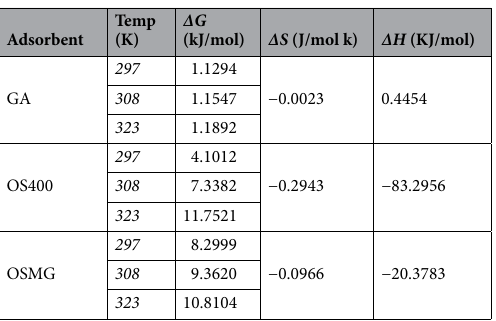
Table 8. Thermodynamic parameters for adsorption of MB dye into GA, OS400 and OSMG.